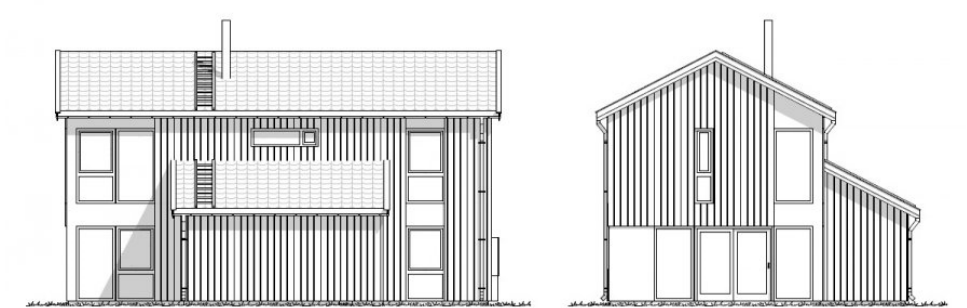
Figure 3. Typical residential building in Norway, facades (Source: Norgeshus).